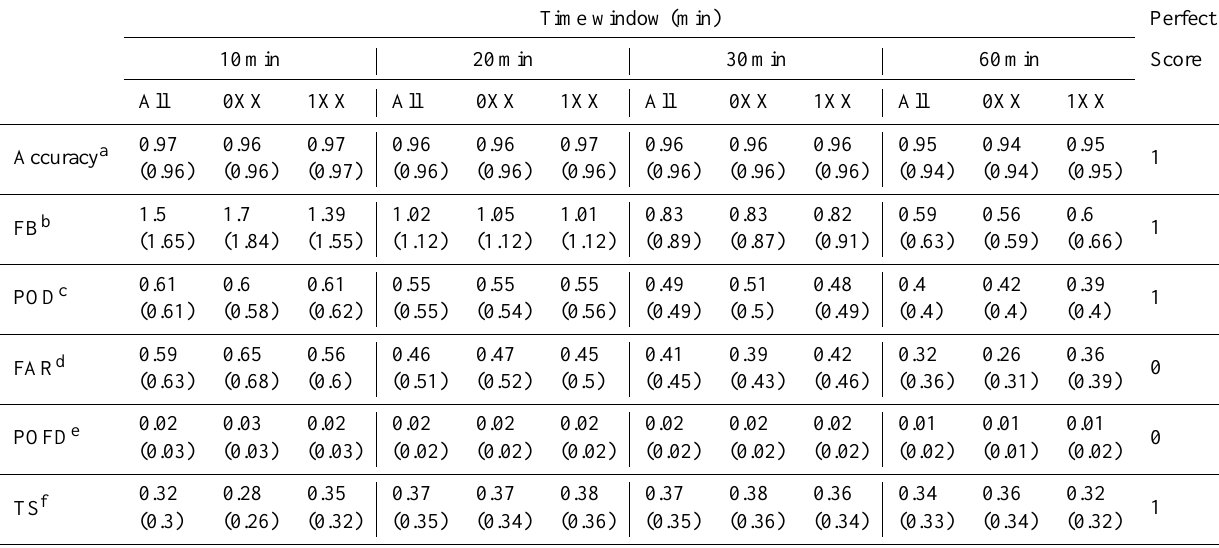
(i.e., skill scores) based on the counts of hits ( YY ), misses ( NY ), false alarms ( YN ) and correct rejections ( NN ) in- ferred from contingency matrices at timescales ranging from 10 to 60 min: accuracy, frequency bias (FB), probability of detection (POD), false alarm ratio (FAR), probability of false detection (POFD), and threat score (TS). The equations to calculate the skill scores are included as footnotes to Table